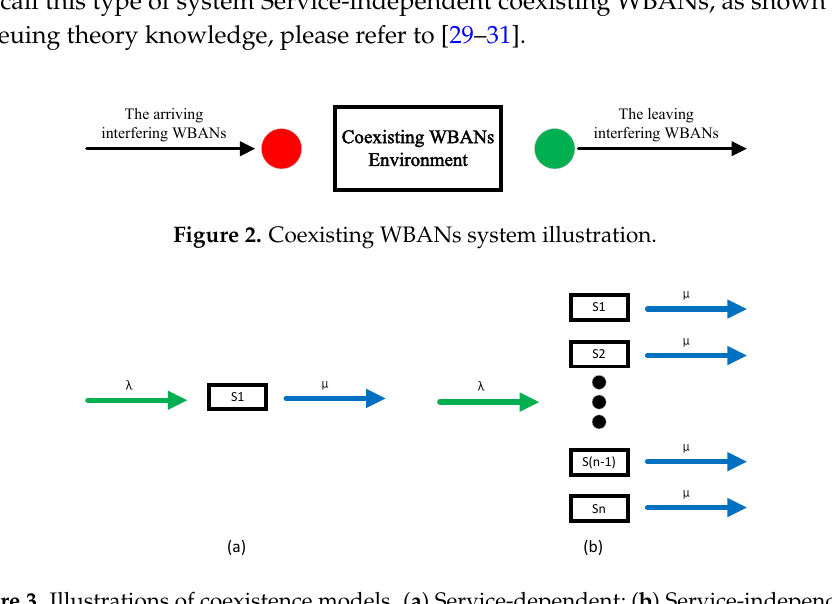
Figure 3. Illustrations of coexistence models. ( a ) Service-dependent; ( b )